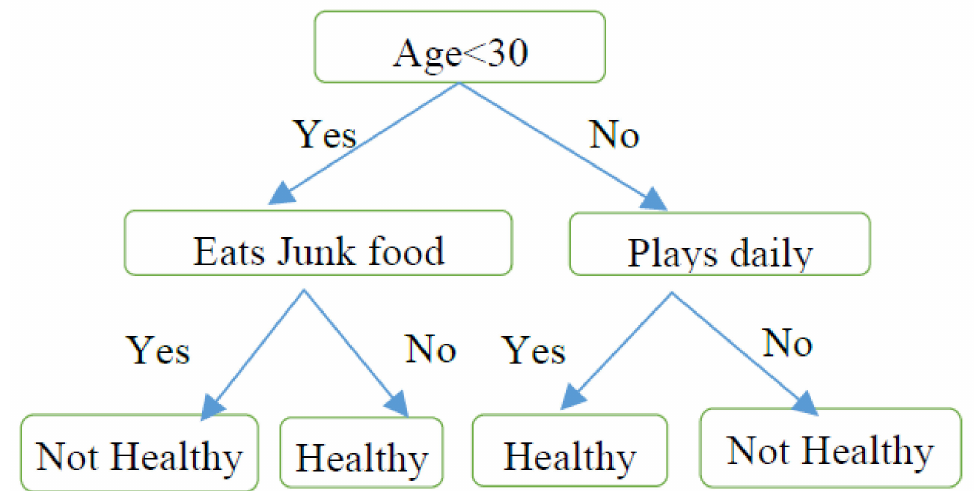
Figure 3. Decision making in personal